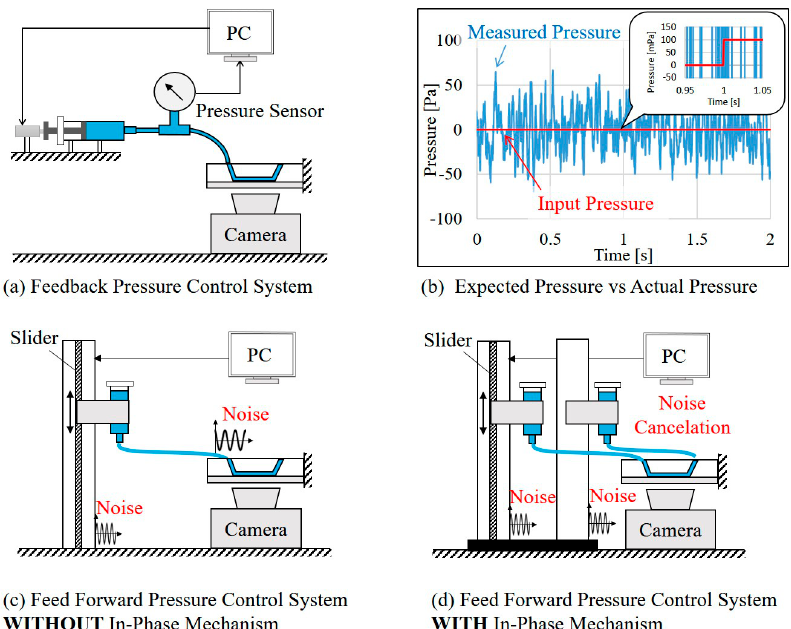
Figure 1. The conventional pressure system and the proposed system. ( a ) Feedback-controlled pressure system; ( b ) The control resolution is limited by sensor resolution. The blue signal is an example of measured pressure by a commercial pressure sensor; ( c ) Conventional gravity-driven pressure system; ( d ) The proposed system with in-phase noise cancelation.